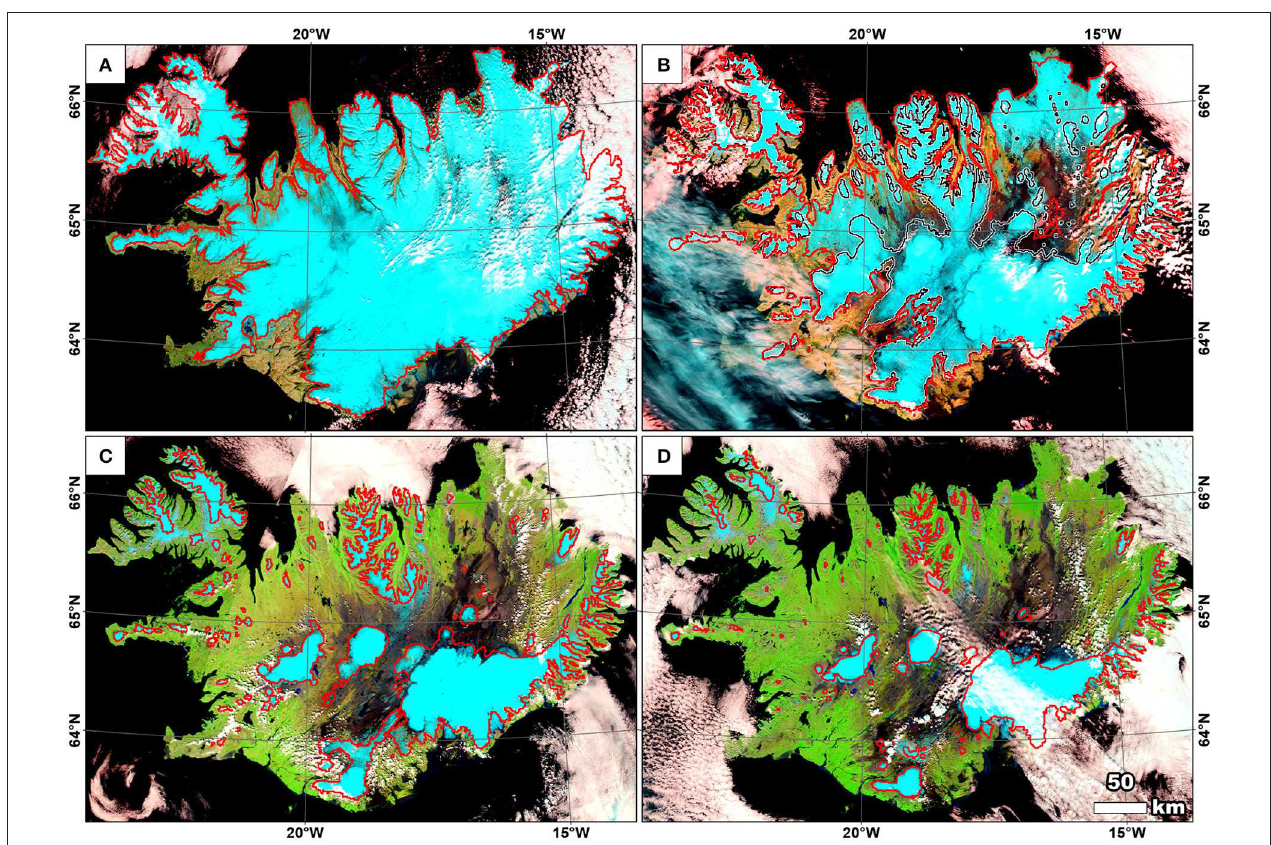
FIGURE 4 | Validation of snow extent in the year 2000: (A) 12.04.2000; (B) . Red line: 19.05.2000, Black line with a white border: 26.05.2000; (C) 23.06.2000; (D) 10.07.2000. Backgrounds: MODIS Aqua/Terra FCCs 721 from the same dates as the red lines. Image courtesy of NASA Worldview. For days when there was large disagreement between observed and modelled snow extent (red lines), a black line with a white border was added for a week before or after if the correspondence between modelled and observed snow extent